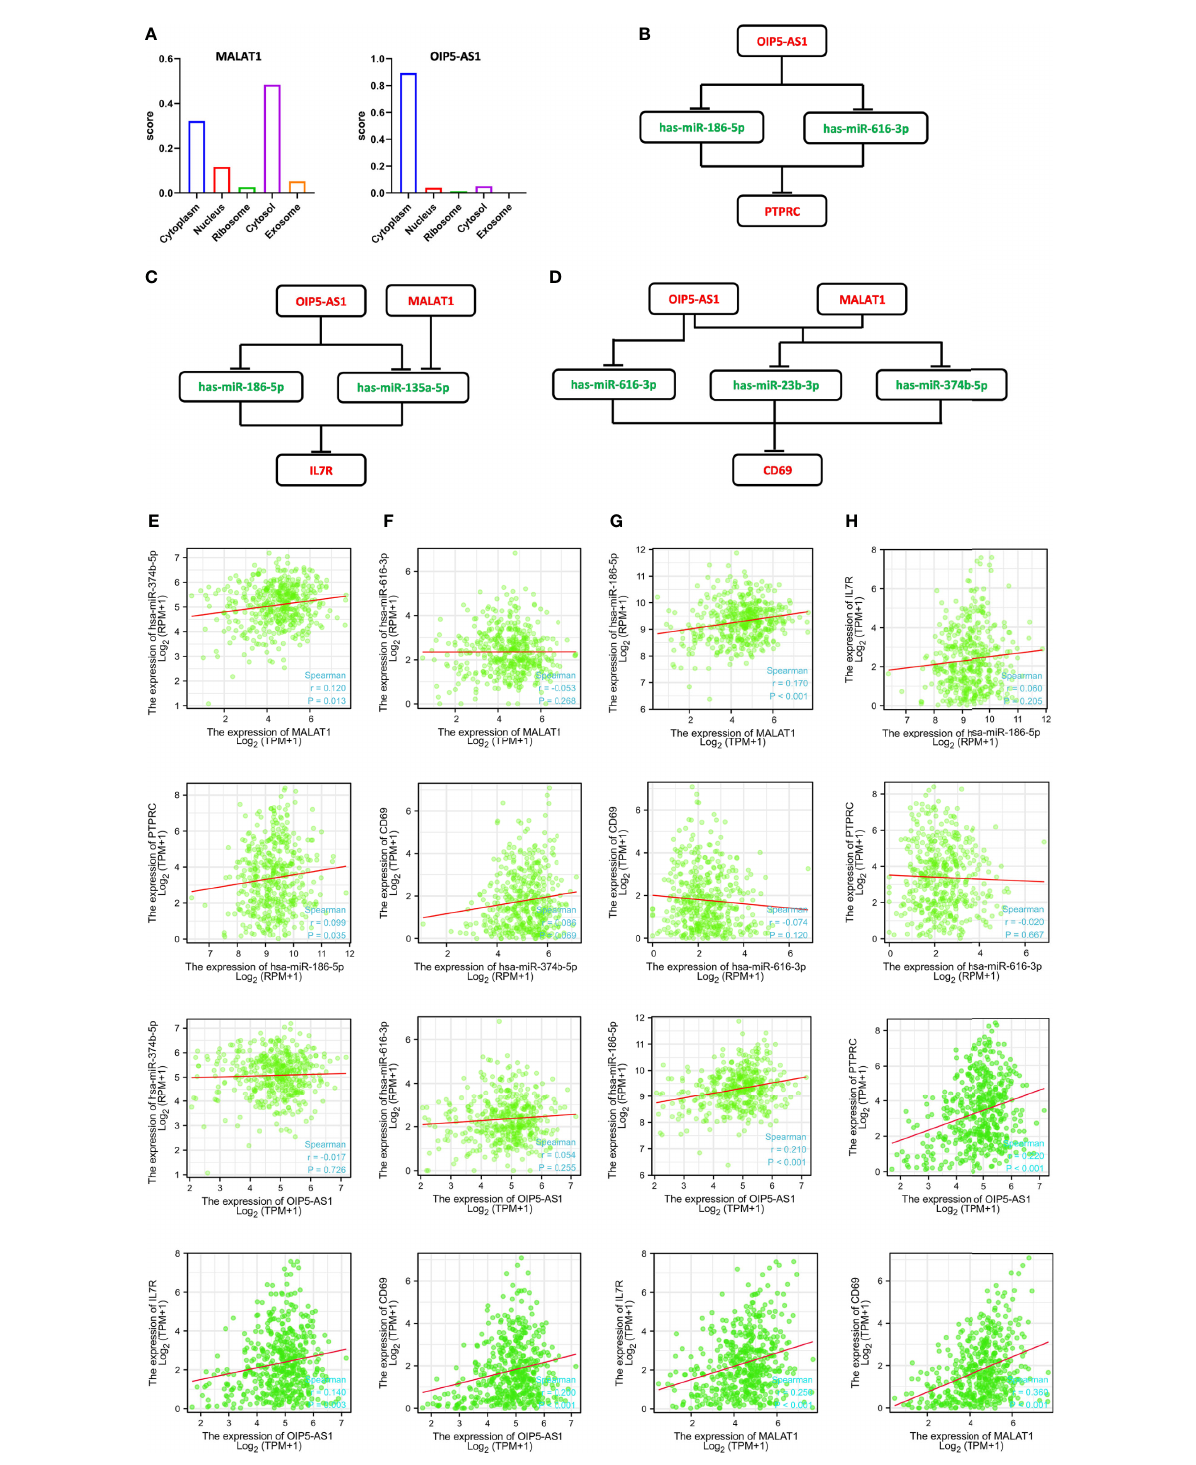
FIGURE 7 Construction and correlation analysis of the ceRNA network. (A) Cellular localization for two hub-lncRNAs ( MALAT1 and OIP5-AS1 ) predicted using lncLocator. (B – D) Schematic representation of the ceRNA networks. Green indicates downregulated and red indicates upregulated RNAs in SKCM. (E – H) Interaction correlation analysis between the ten predicted RNAs in SKCM, consistent with the predicted ceRNA